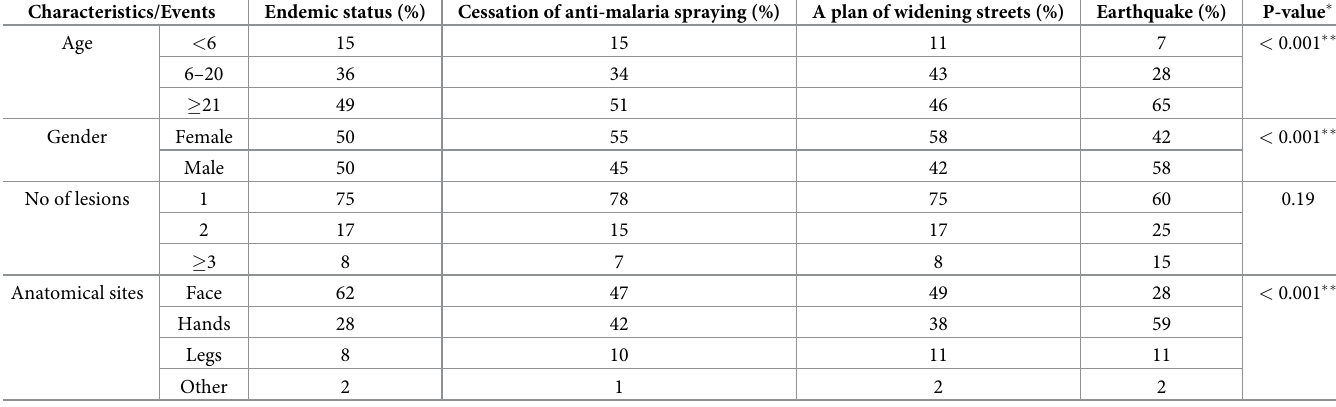
Table 2. Representing age groups, genders, the number of lesions, and anatomical location of lesions in cases with anthroponotic cutaneous leishmaniasis in Bam, southeastern Iran. Characteristics/Events